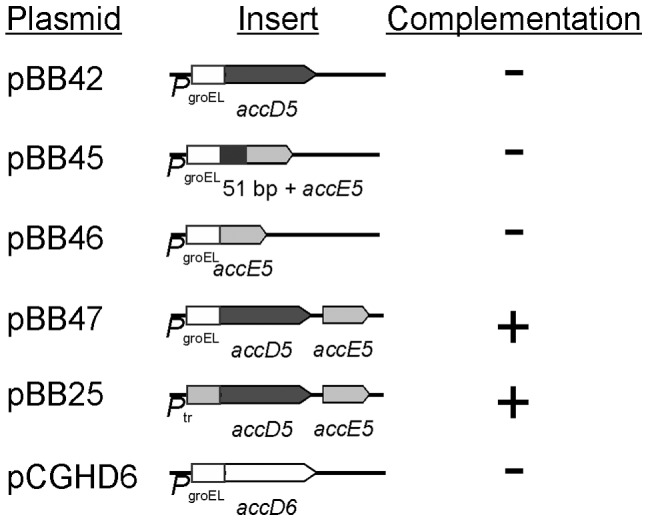
Complementation of the accD5-accE5 conditional mutant.Schematic representation of the pMP395 derived constructions used in the complementation studies.